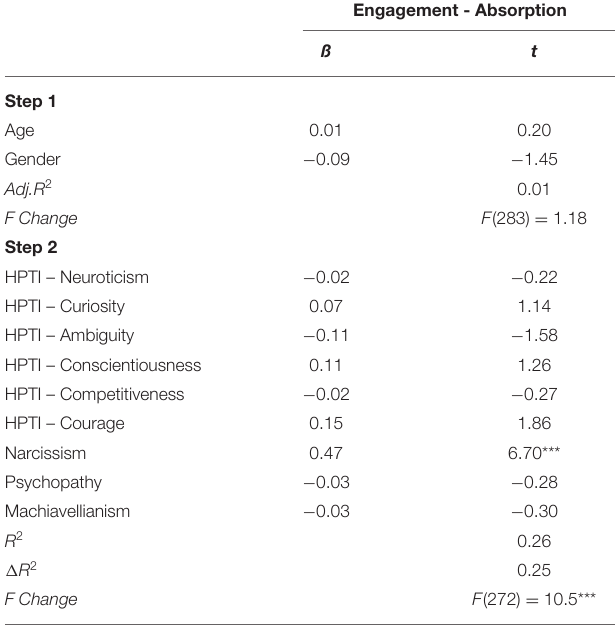
TABLE 5 | Regression of HPTI and Dark Triad on UWES